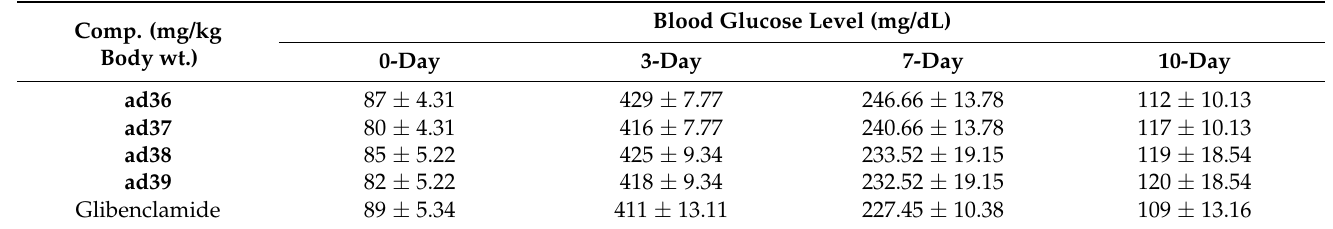
Table 46. Antidiabetic potential of the compounds ( ad36 – ad39 ) in streptozotocin-induced diabetes in